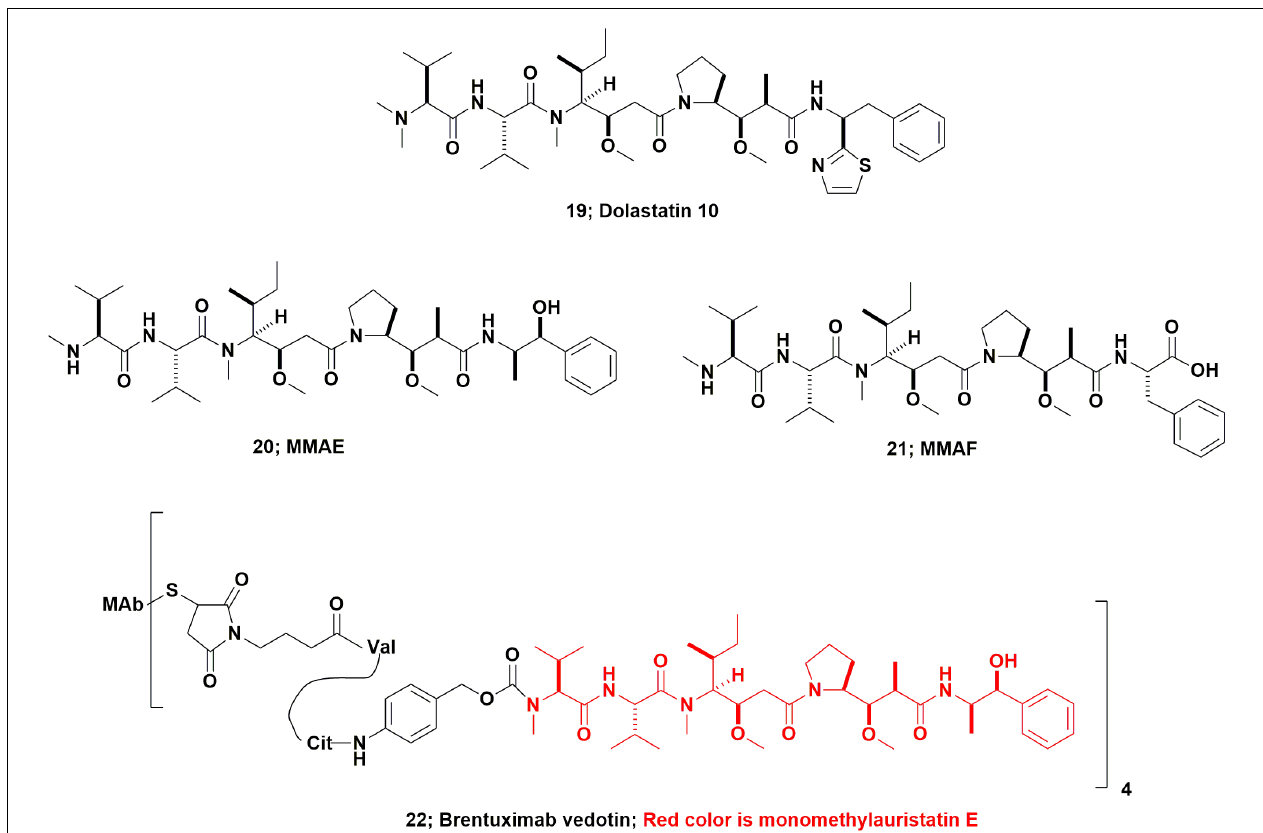
FIGURE 6 | Dolastatin 10 and